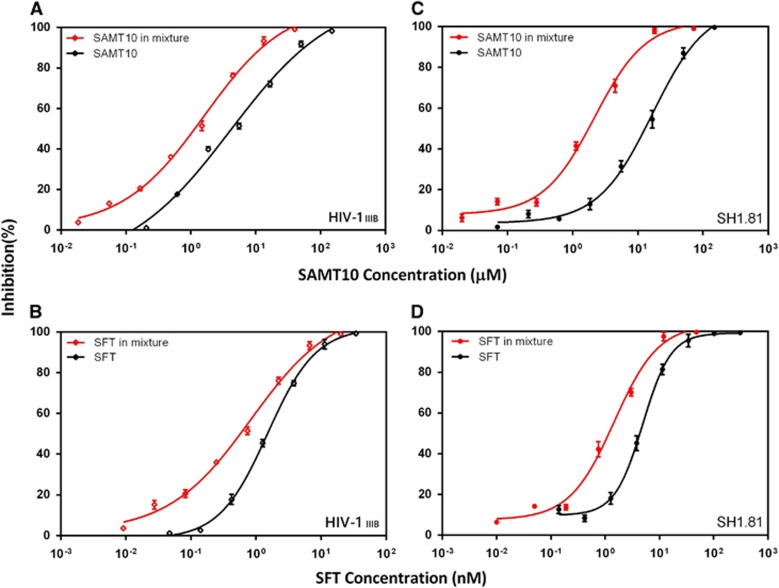
Efficacy of treatment of SAMT10 alone or in combination with SFT to prevent viral infection. (A, B) SAMT10 or SFT alone or in combination against the HIV-1IIIB laboratory-adapted strain (subtype B, X4). (C, D) SAMT10 or SFT alone or in combination against HIV-1-pseudotyped virus SH1.81 (01_AE, R5). Plots of antiviral activity for SAMT10 or SFT alone are shown in black, whereas those of the combination are in red. These curves were fit to a sigmoidal curve using a nonlinear least squares regression to estimate the drug EC50. The range of doses for each compound tested was a 10-fold serial dilution based on EC50. The results are representative of three independent experiments, and each experiment was performed in triplicate. SH1.81 indicates the HIV-1-pseudotyped virus SH1.81. 50% effective concentration, EC50; S-acyl-2-mercaptobenzamide thioester-10, SAMT10; sifuvirtide, SFT.